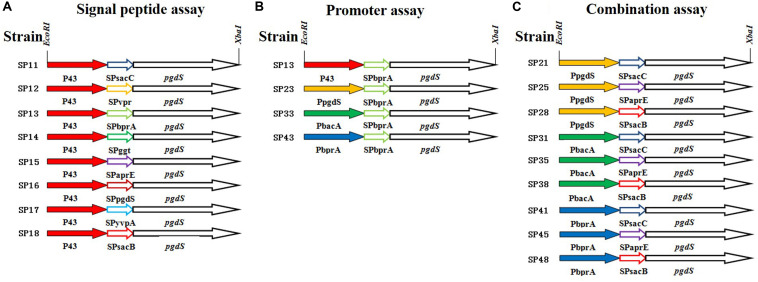
The details of PgdS expression cassettes constructed by manipulating its promoter and signal peptide independently and in combination. (A) Signal peptide assay containing SPsacB, SPaprE, SPggt, SPvpr, SPbprA, SPyvpA, SPpgdS, and SPsacC using P43 promoter; (B) promoter assay containing P43, PbacA, PpgdS, and PbprA using BprA signal peptide; (C) combination assay containing three promoters (PpgdS, PbacA, and PbprA) and three signal peptides (SPsacB, SPpgdS, and SPsacC). Different colors indicate different promoters or signal peptides, and the named rule of strains: first number means promoter, second number means signal peptide.